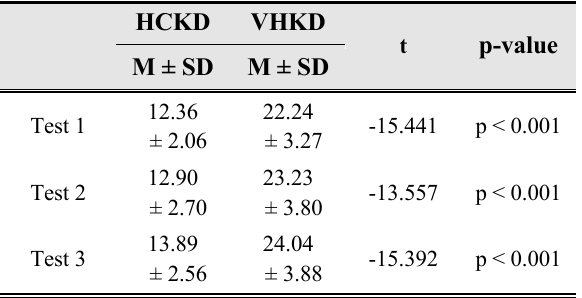
Comparison between HCKD and VHKD